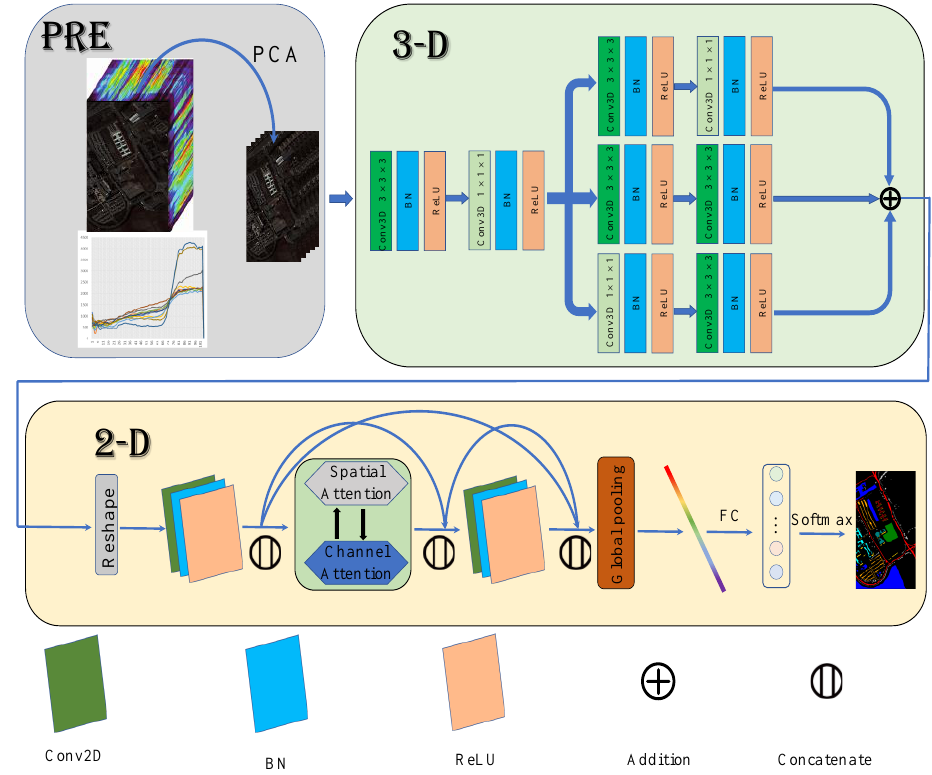
Figure 4. The Flowchart of MFFDAN network.